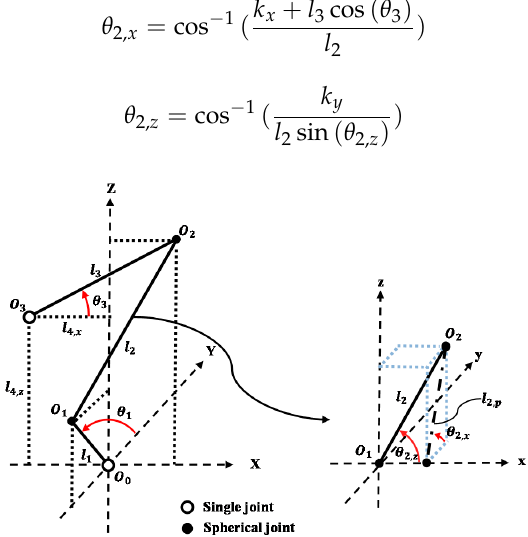
Figure 9. Schematic kinematics of spatial four-bar link-based flapping mechanism.